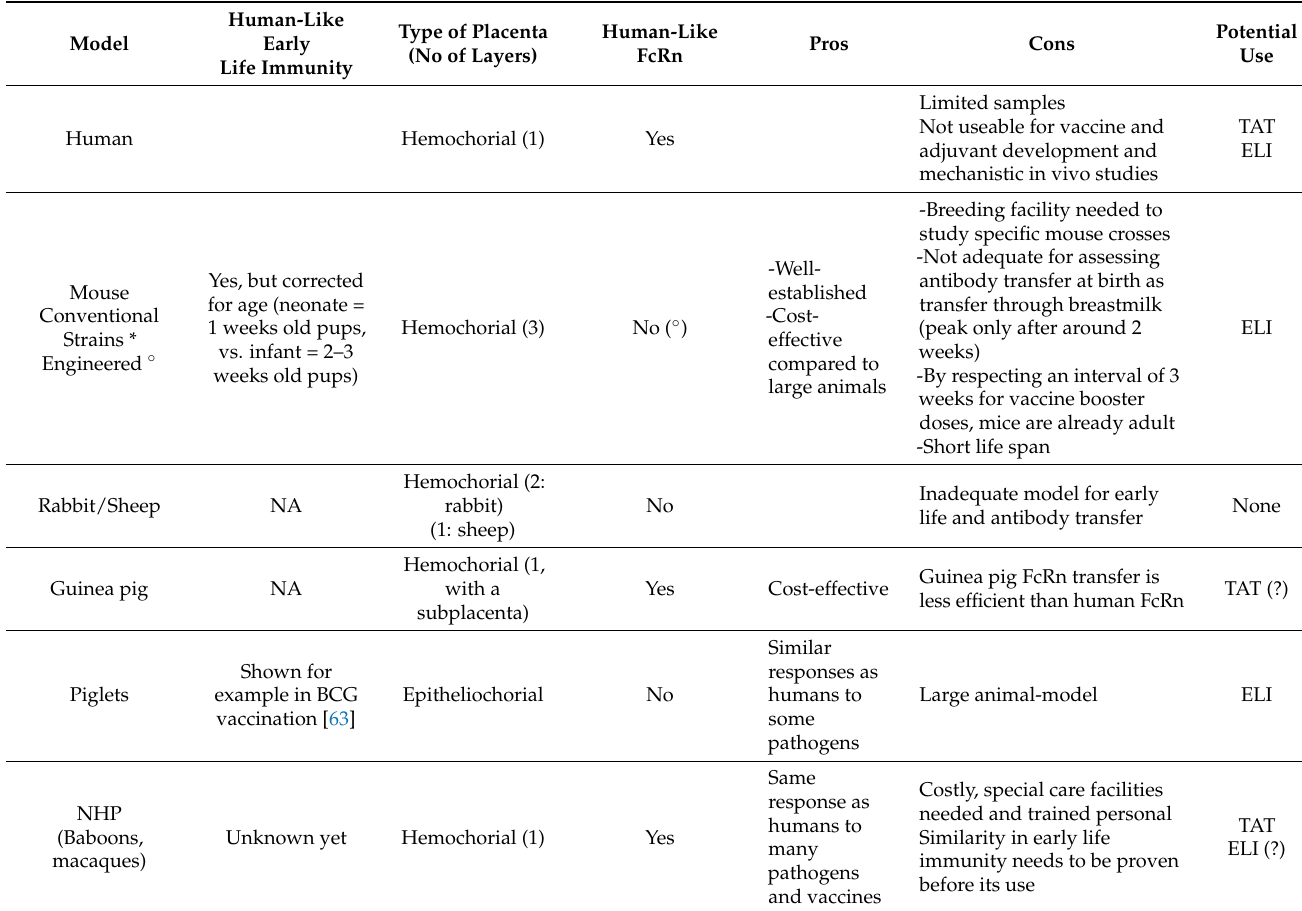
Table 1. Benefits and limitations of each model for early life immunity and maternal antibody transfer